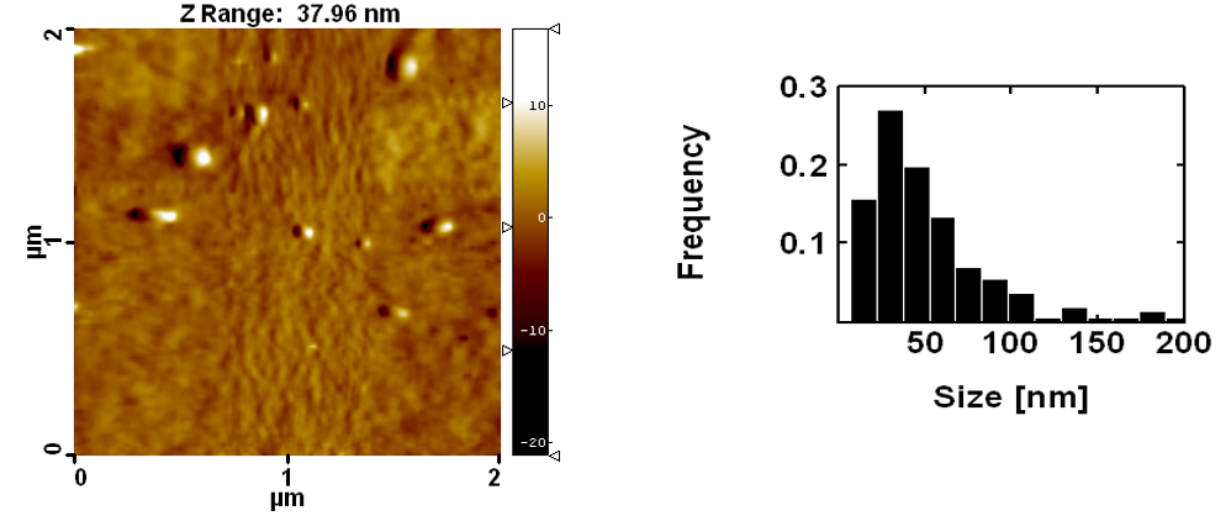
Figure 3. AFM image and size distribution of AuNPs prepared by chemical synthesis.